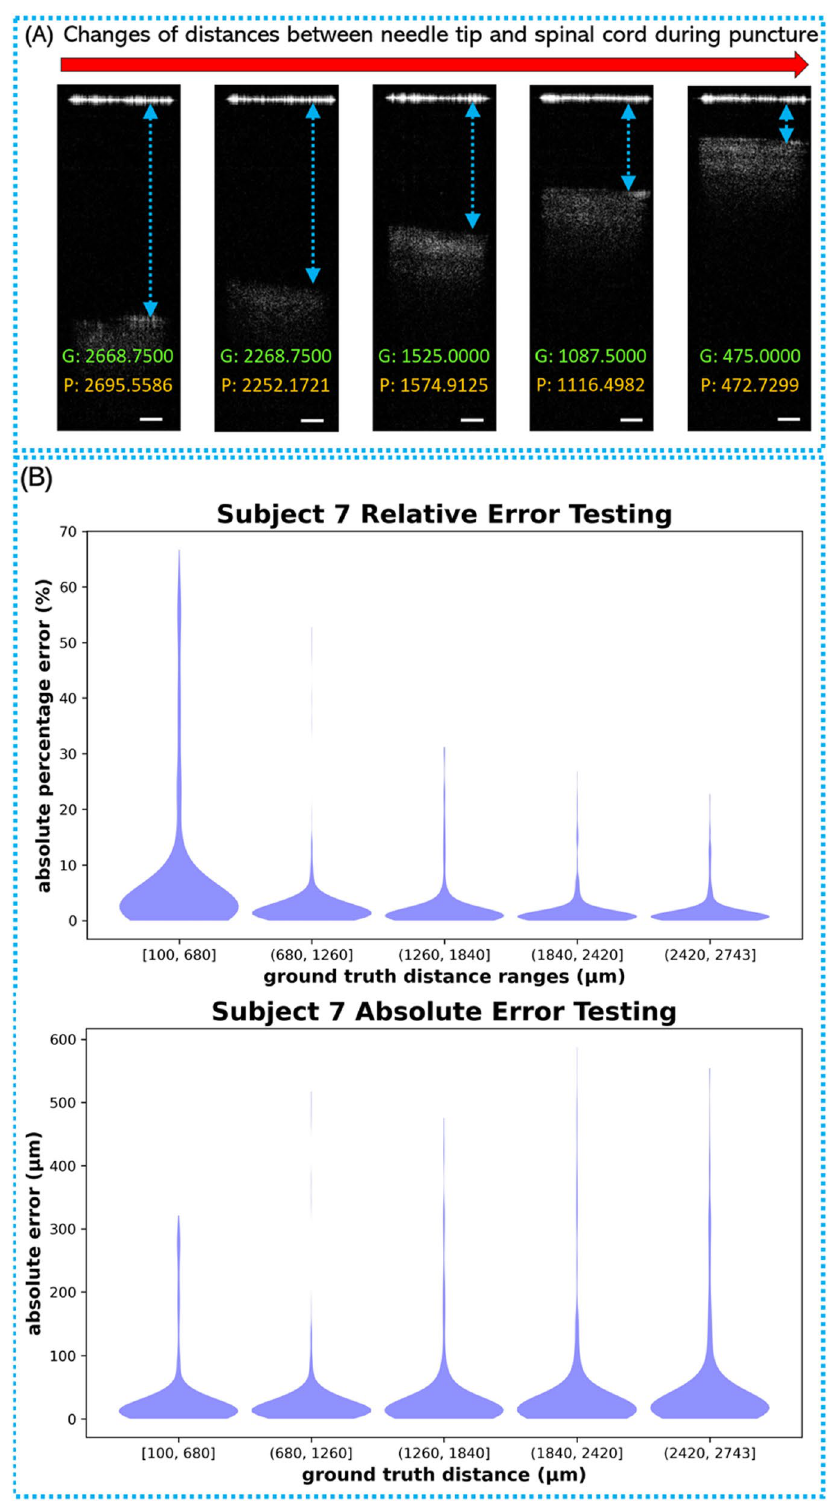
Figure 3. ( A ) Examples of epidural space images with different distances between needle tip and spinal cord surface. G: labeled ground truth value (μm); P: prediction value (μm); Scale bar: 250 μm. ( B ) The distribution of the predicted absolute percentage errors and absolute error in testing fold 7 with 3000 testing